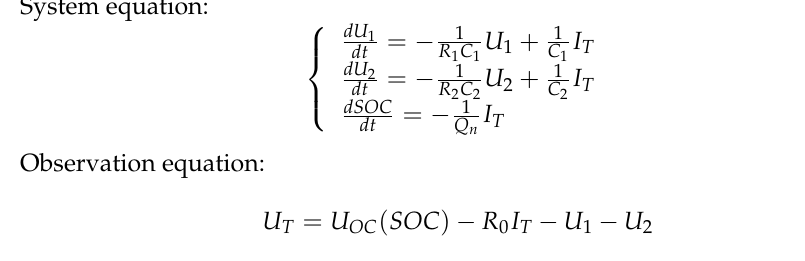
Figure 1. Second-order RC equivalent circuit model diagram.